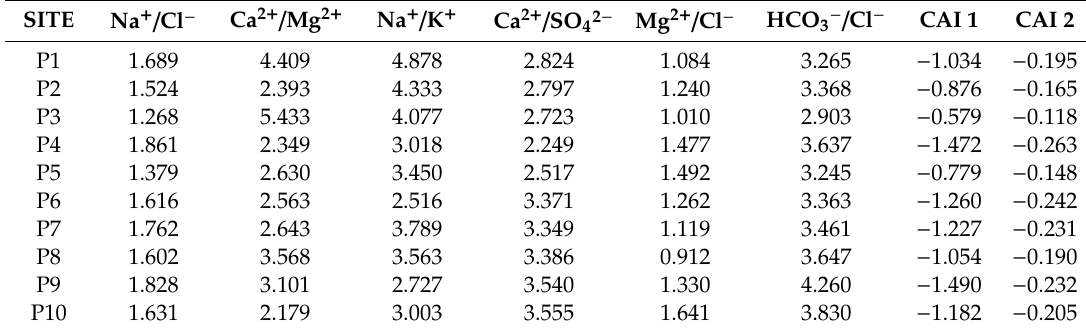
Table 10. Molar ratio values of the groundwater of Zamora, Michoac á n.